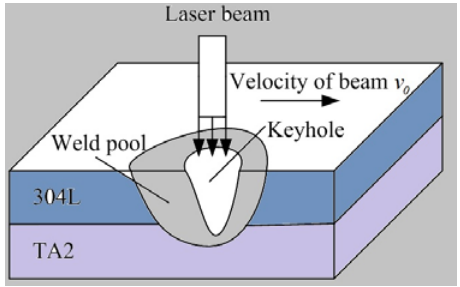
Figure 1. Schematic diagram of laser overlap welding.